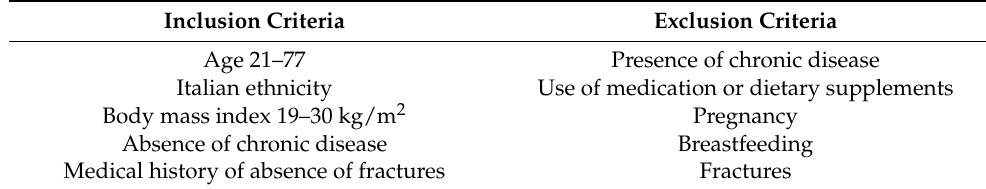
Table 1. Characteristics of the study participants defined by eligibility